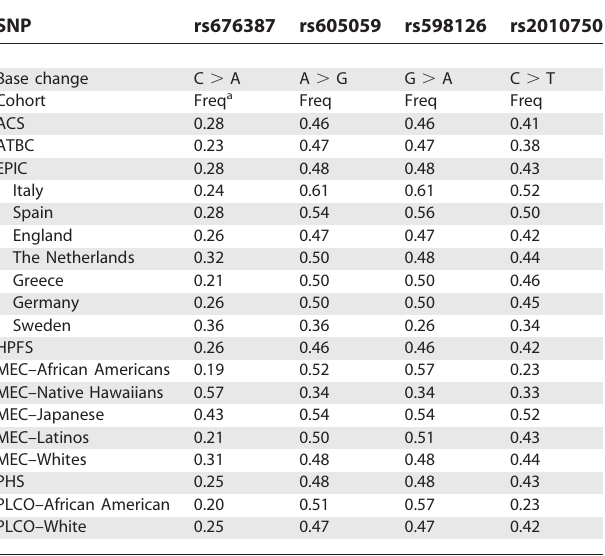
Table 2. Characteristics of the htSNPs for HSD17B1 SNP rs676387 rs605059 rs598126 rs2010750 Base change